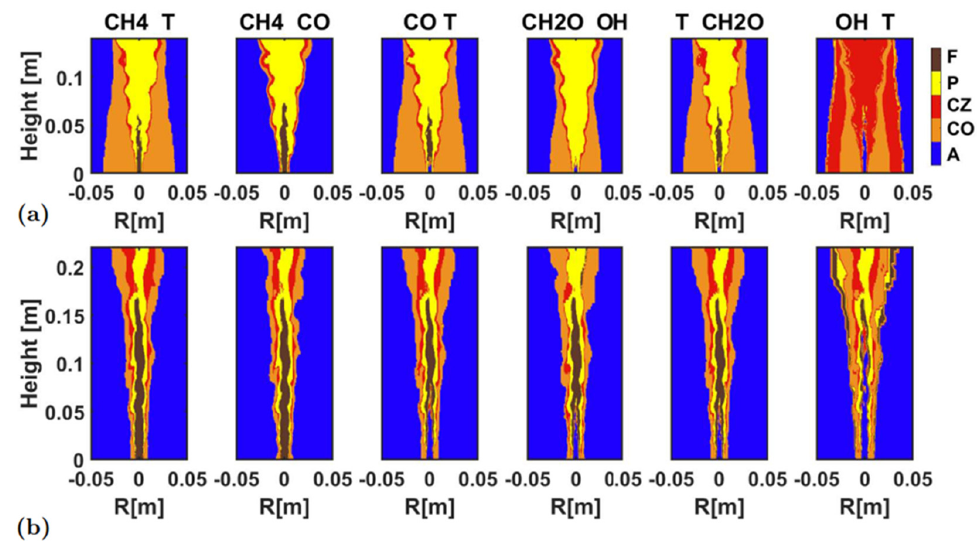
Figure 13. CRI results of BPNN with two-dimensional input: ( a ) HM1; ( b ) Sandia Flame D.